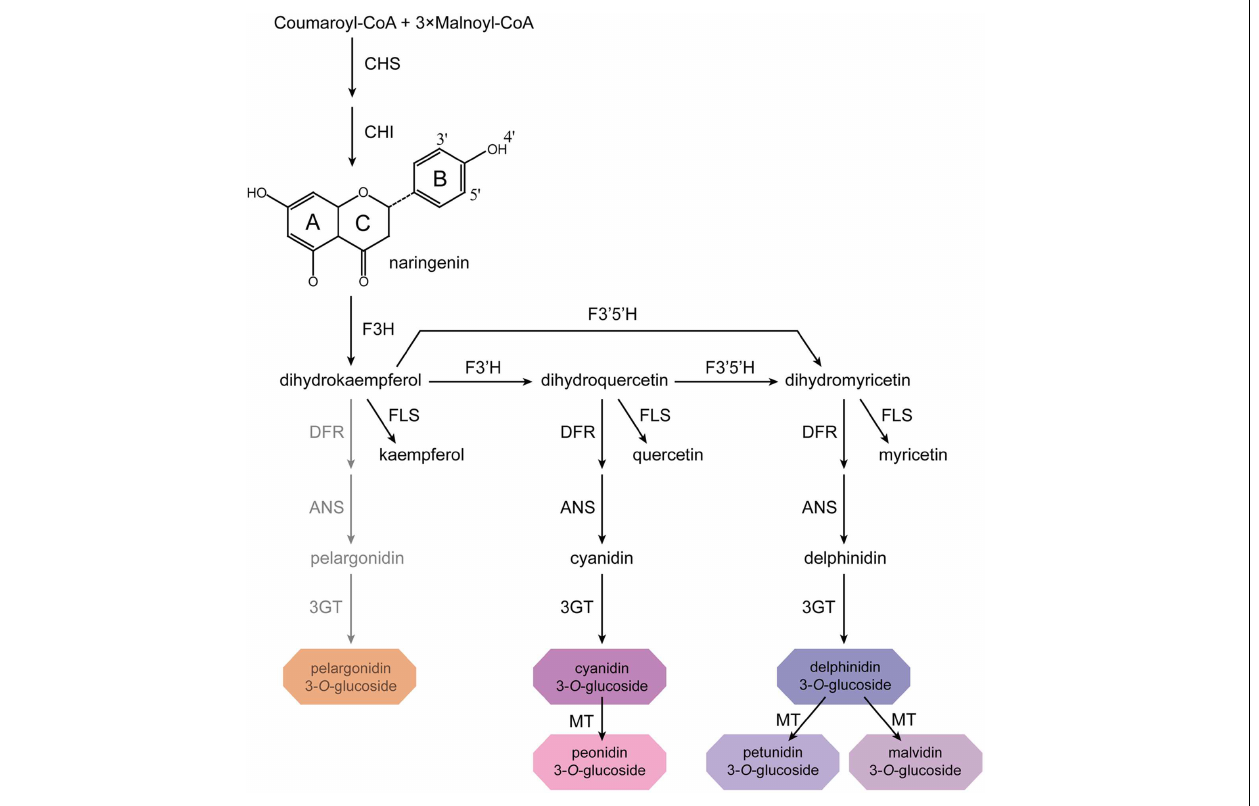
FIGURE 1 | Proposed flavonoid pathway in Freesia hybrida flower. Hoary areas indicate the biosynthesis of pelargonidin-based pigments is